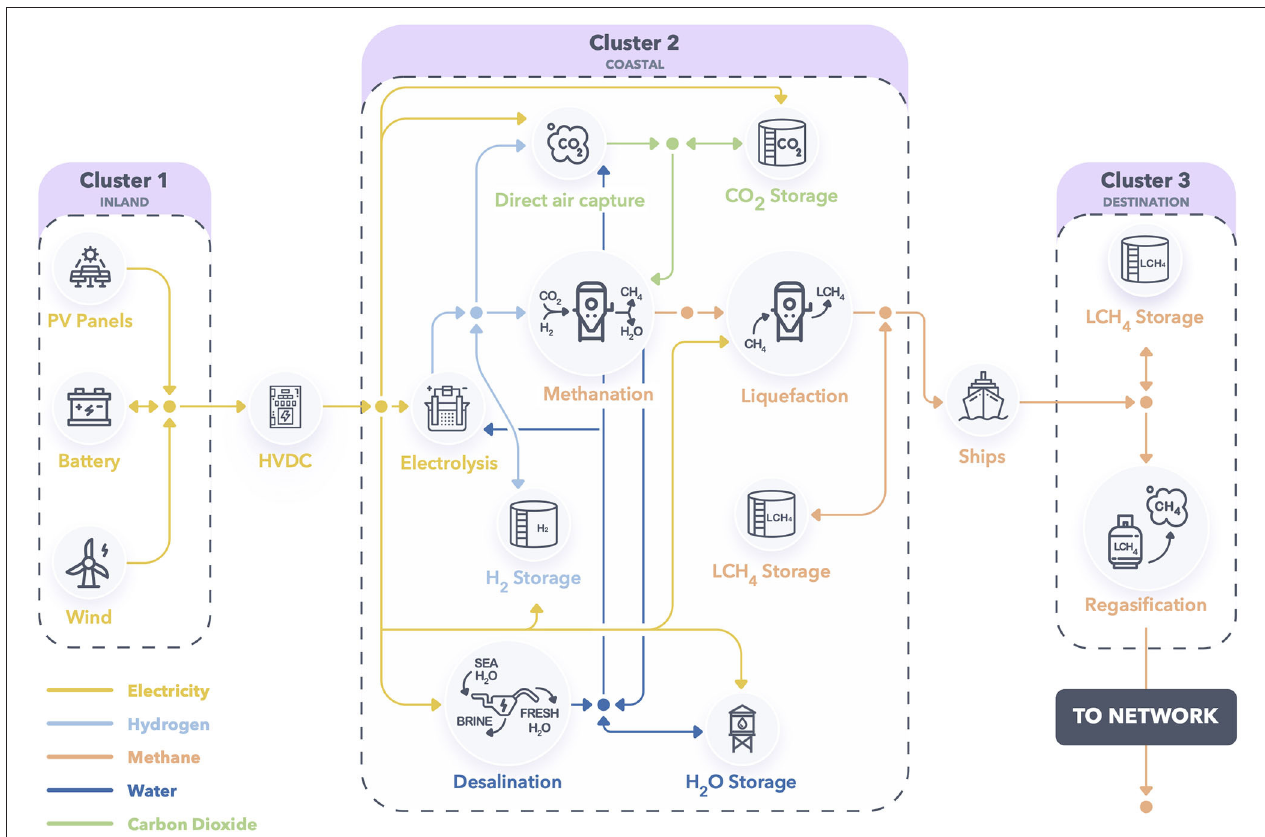
FIGURE 3 | Remote hub system configuration. Icons represent conversion or storage nodes, while bullets and arrows schematically represent conservation hyperedges.